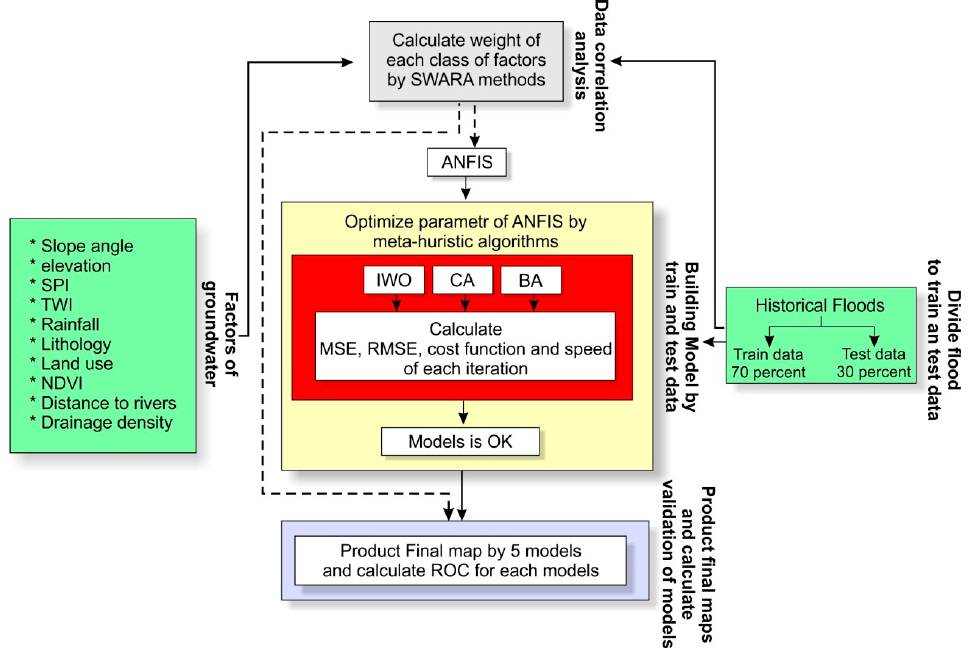
Figure 2. Methodological flowchart used in this study for FSM in the Haraz watershed.